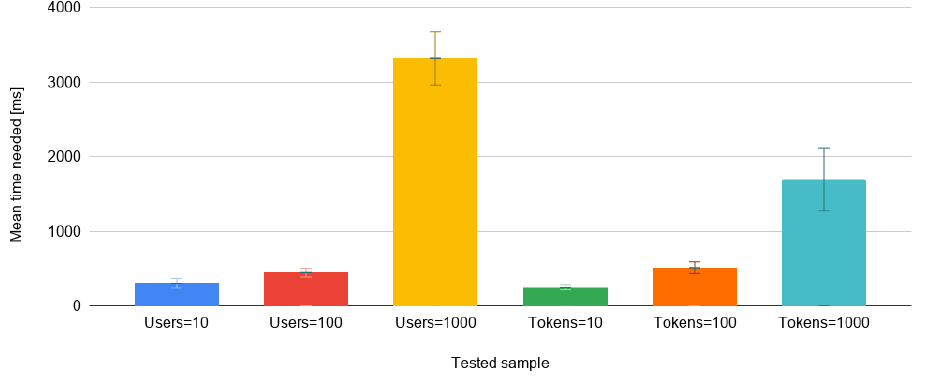
Figure 4. User and token registration transfer